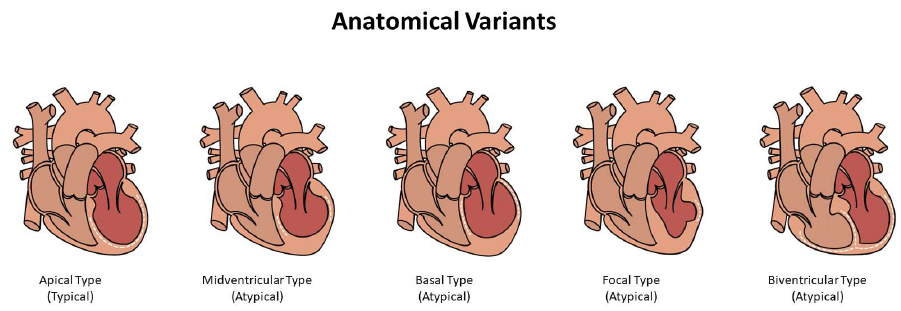
Figure 5. Anatomical Variants of TS (Typical and Atypical